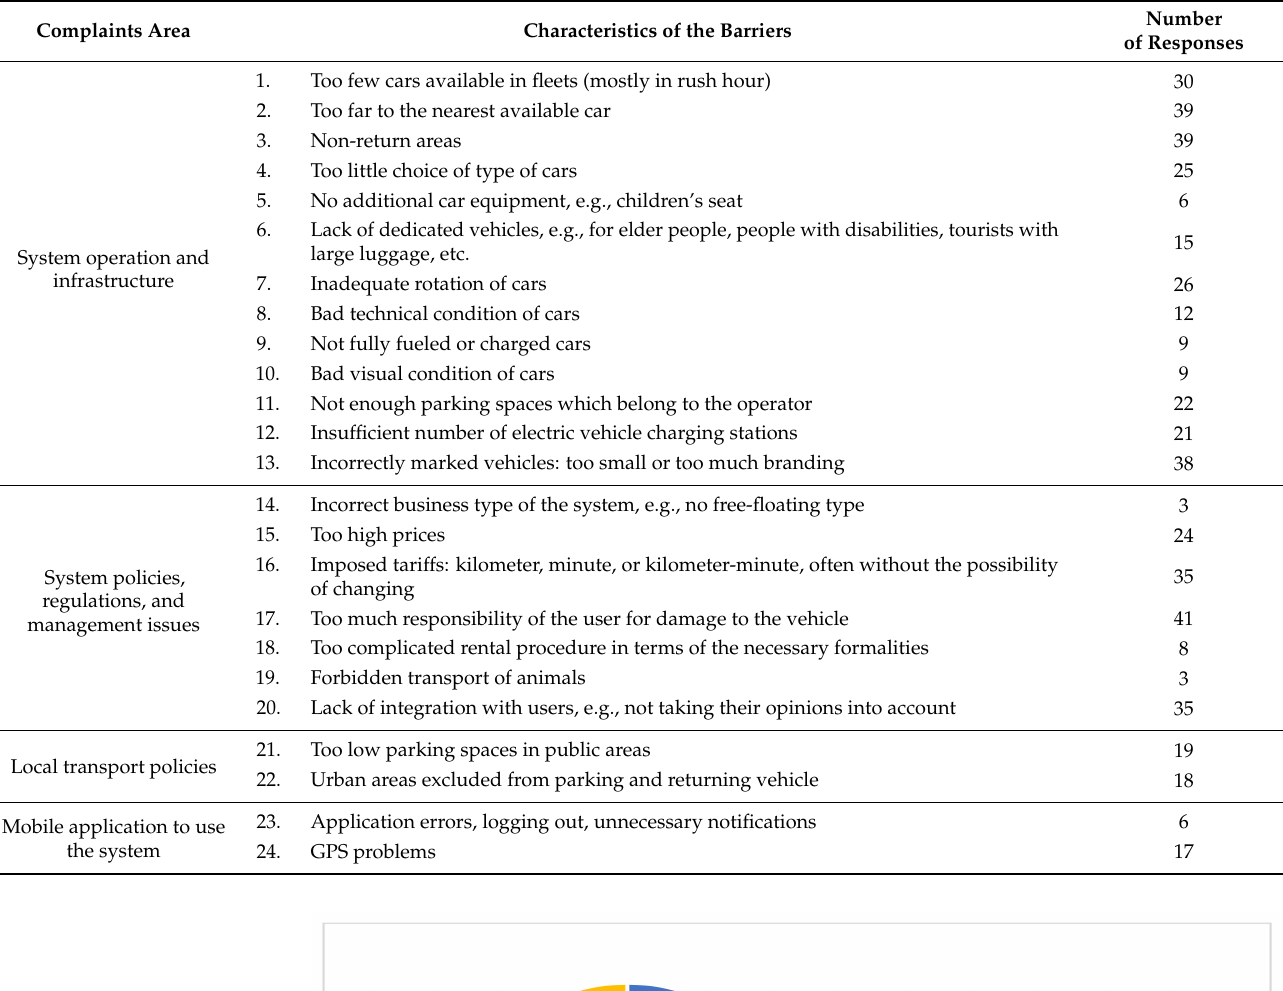
Table 5. Areas of complaints about car-sharing systems.